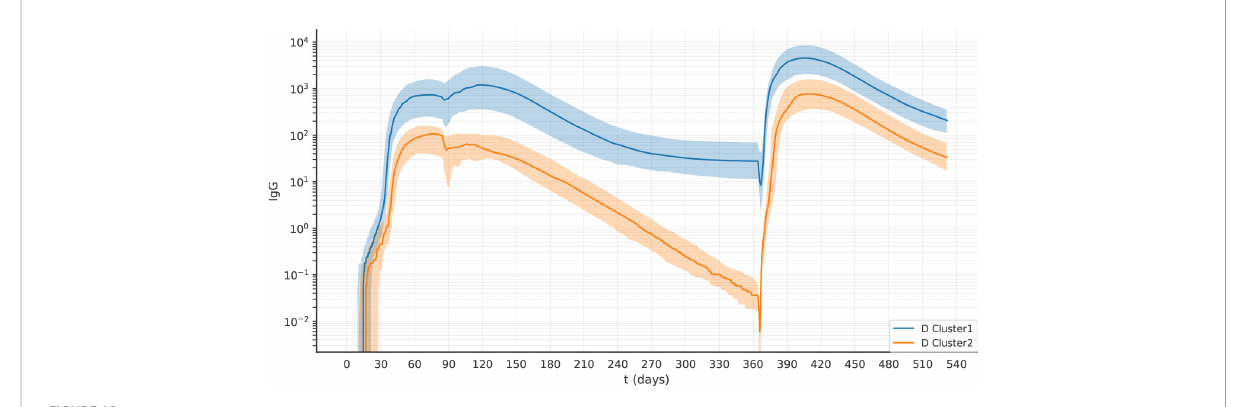
FIGURE 10 After two doses of vaccine, the virtual individuals can still be separated into clusters 1 and 2, representing antibody sustainers and decayers . The plots represent the median (lines) and IQR (shaded area) of variable Ab in clusters 1 and 2 in experiment